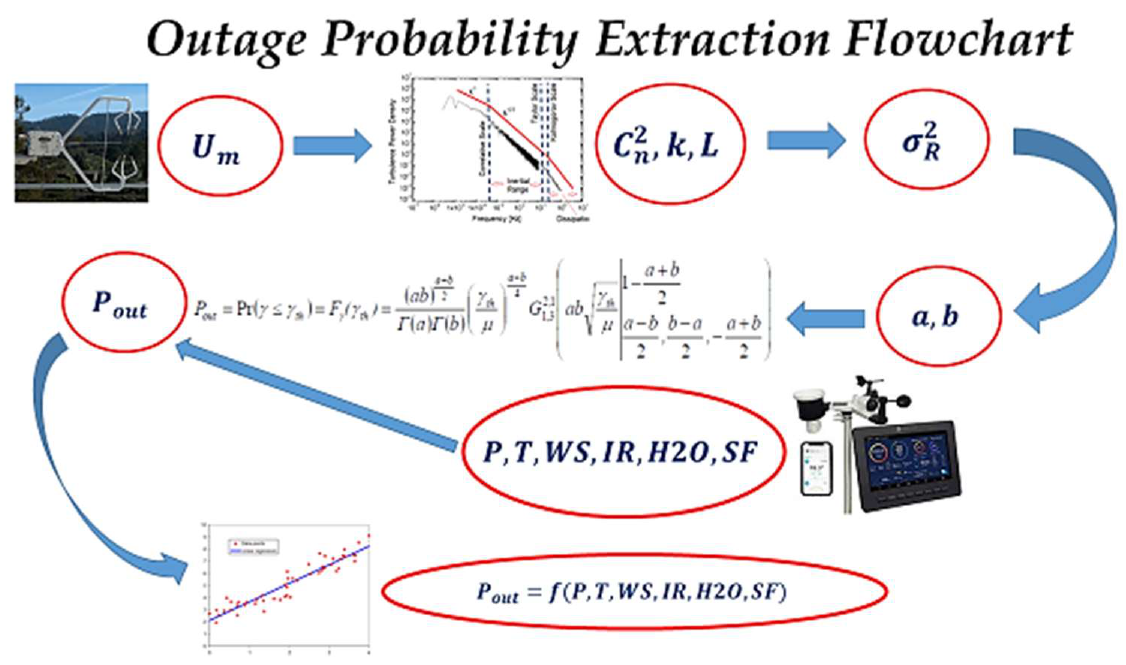
Figure 10. The outage probability of a notional FSO link extraction flowchart. The sonic anemometer measurement allows for the C 2 n extraction and consequently the Rytov variance which is used for the alpha and beta parameters. Equation (18) applies those values and calculates the outage probability which later on is modeled based on the experimentally measured atmospheric parameters. Table 2. Descriptive Statistics for P out